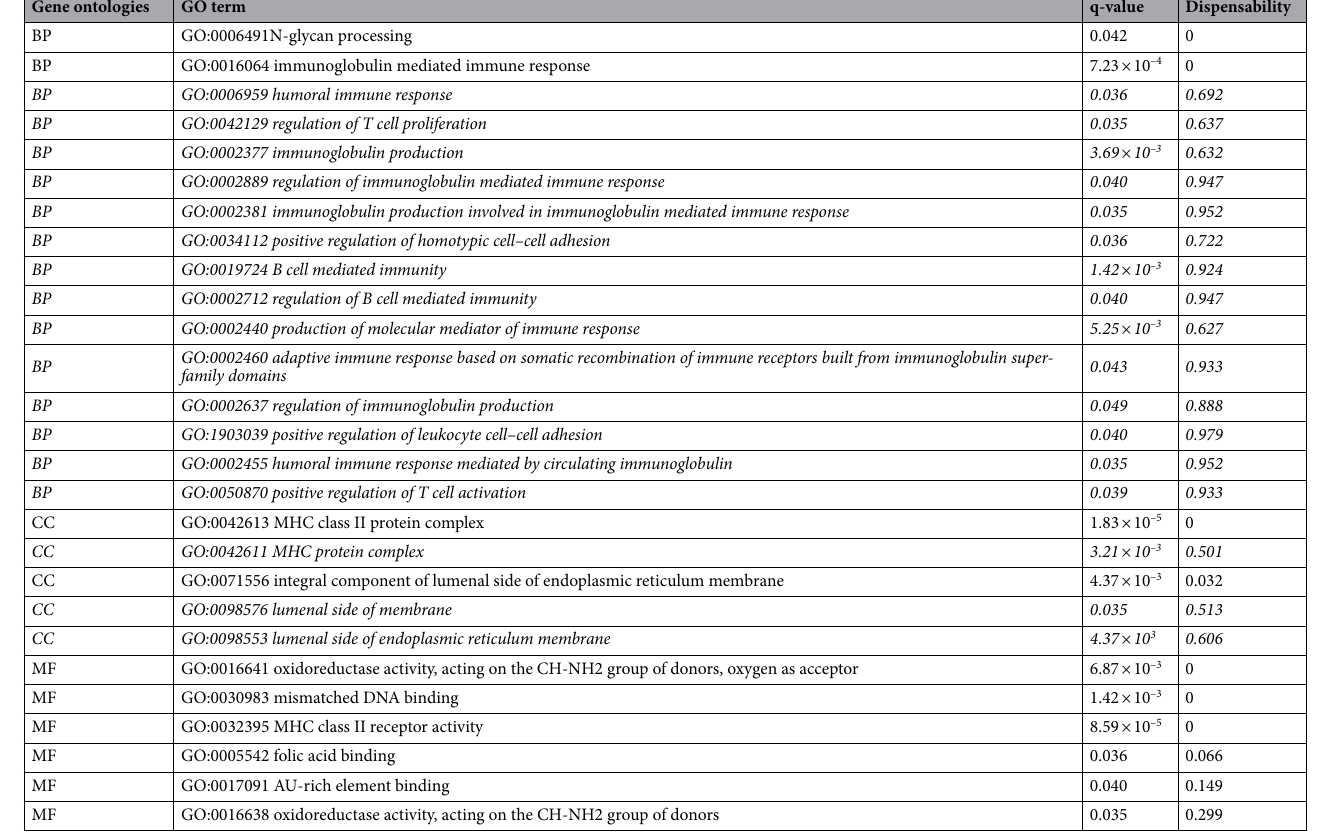
Table 3. Significantly enriched pathways. Gene Ontologies: Molecular Function (MF), Biological Process (BP), Cellular Component (CC). Dispensability represents a measure of the non-redundancy of a GO term with respect to other semantically close terms. Representative, non-redundant GO terms are given in black, the other cluster members are in